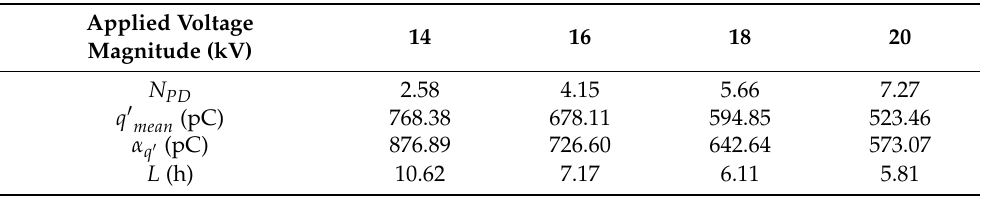
Table 4. Summary of the typical simulation results for each applied voltage magnitude in the second case study.